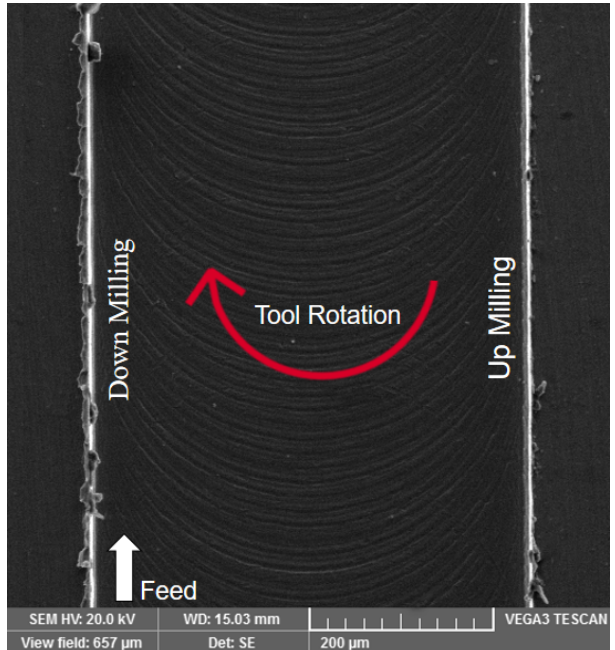
Figure 5. Burr formation at down milling and up milling side during micro-milling of Ti-6Al-4V ( f z = 8µmtooth − 1 , V c = 7 . 5mmin − 1 , a p =